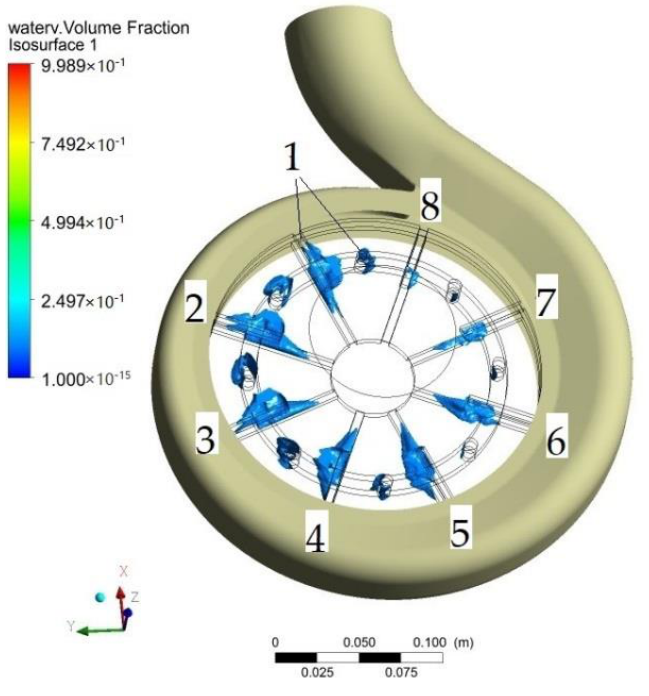
Figure 8. Distribution of cavitation iso-surface inside the impeller of disc pump (Q d = 80.9 m 3 /h). Figure 8 shows that in the steady calculation for the BEP (best efficiency point) flow rate (Q d = 80.9 m 3 /h), the volume fraction distribution corresponding to the value of 10% occurs close to the inner straight blade and the connection column, and the surface of the bubble is defined as the isosurface with 10% of the air volume fraction. It can be seen from Figure 9 that the bubbles generated by cavitation mainly appear in the middle of the rear straight blade, and the cavitation at the inlet and outlet sides of the straight blade is not obvious. In addition, the negative pressure is that exists behind the connection column corresponds to large cavitation flows. As previously mentioned, for low flow rate results, the relative position of the impeller and the volute is an important parameter for the inhomogeneous spatial distribution of cavitation areas. The large section area of the